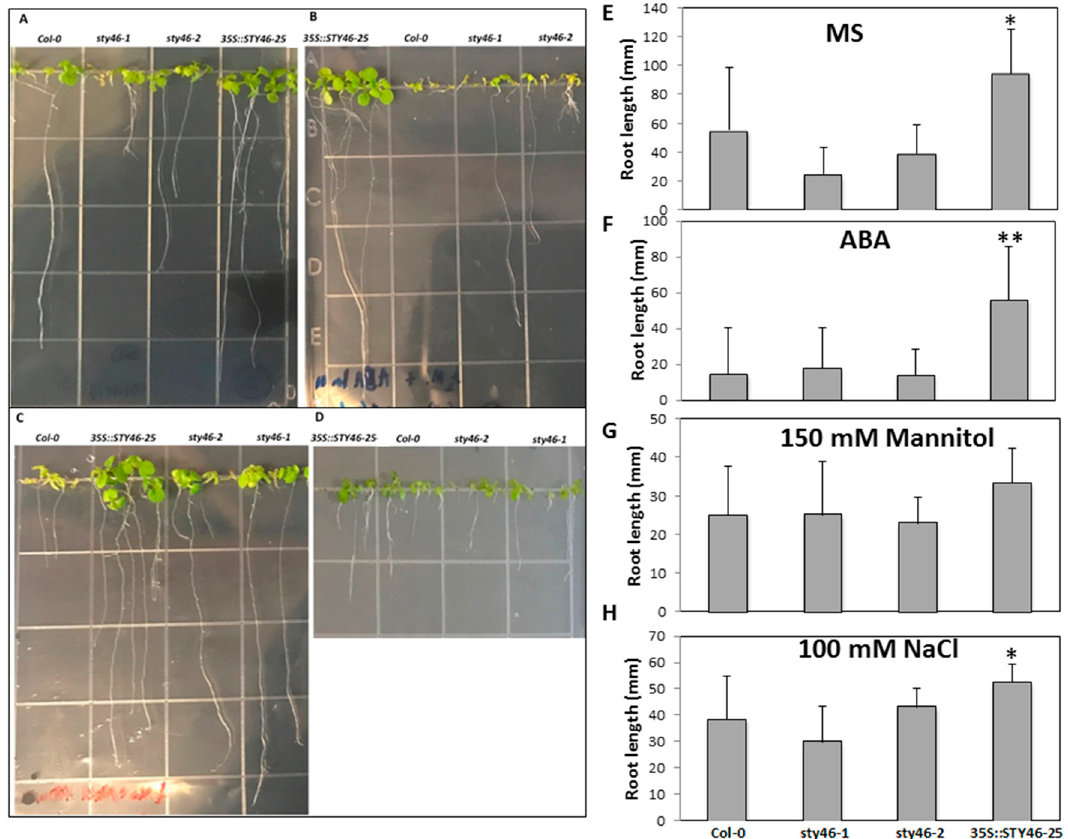
Figure 5. The morphology and root length of STY46 transgenic seedlings grown under stress. Wild type Col-0, STY46 mutant lines (STY46-1, STY46-2), and STY46 overexpression lines (35S:STY46-25) were germinated and grown in ½ MS medium without sucrose ( A , E ), ½ MS with 1 µM abscisic acid (ABA) ( B , F ), ½ MS medium with 100 mM NaCl ( C , H ), and ½ MS medium with 150 mM mannitol ( D , G ). Root length in seedling growing under stress. The photos were taken at 21 days old. Differences in root length were determined by quantitative analysis of 15-roots. Shown here is a random sampling of plants. The asterisks indicate statistically significant differences of root length ( E–H ) between transgenic lines and the wild type control ( n = 15, ‘*’, 0.01 < p < 0.05; ‘**’, 0.001 < p < 0.01).